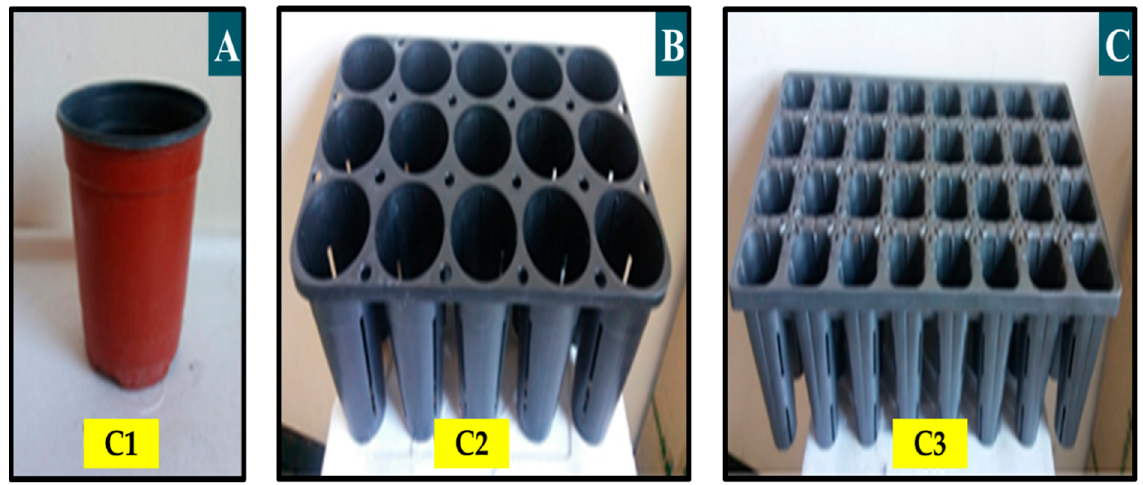
Figure 1. Different size of containers, ( A ) C1, 1000 mL; ( B ) C2, 500 mL; and ( C ) C3, 300